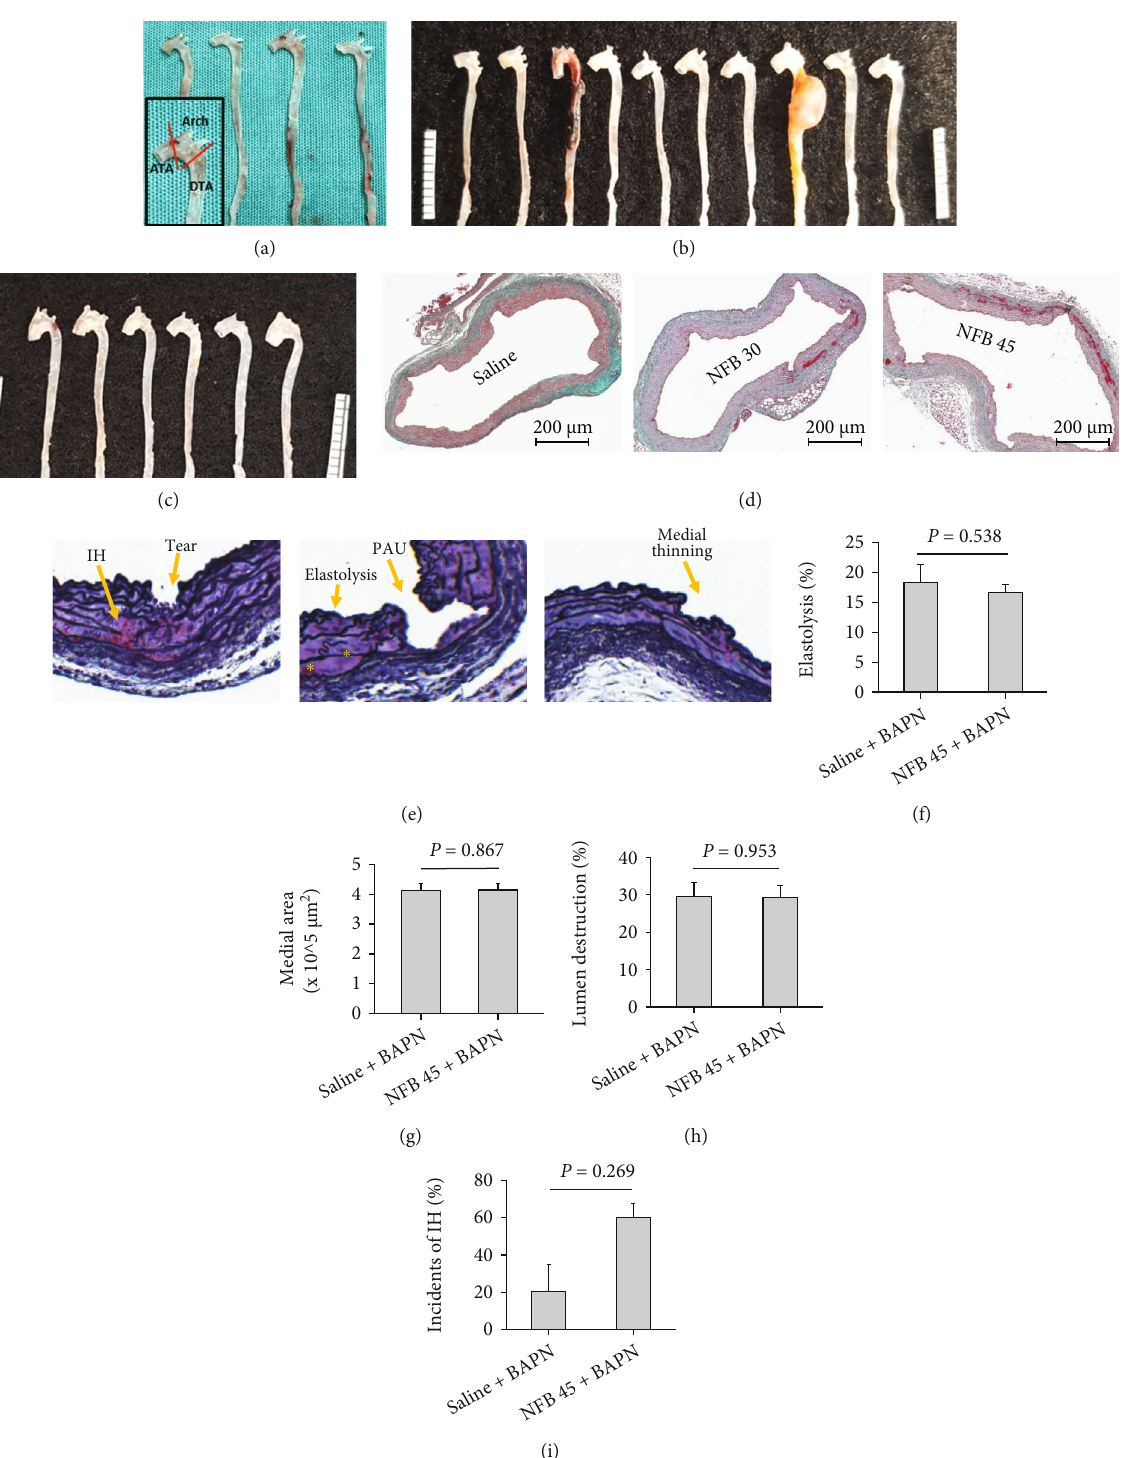
Figure 3: Nicotine free base (NFB) at doses su ffi cient to exaggerate aortic dilation may not worsen medial degeneration. (a – c) Gross appearance of TAADs in mice treated with saline ((a), n = 7 ) or NFB at dosages of 30.0 mg/kg/day (NFB 30, n = 10 , (b)), or 45.0mg/kg/day (NFB 45, n = 10 , (c)). Ruler scale: mm. (d) Masson ’ s staining of TAADs after undergoing the indicated treatments. Note the similarity in medial structural defects between these TAADs. (e) Typical pathologies disclosed with Movat ’ s staining. IH: intramural hemorrhage; PAU: penetrating aortic ulcer. (f – i) Morphometric analyses in TAADs treated with saline ( n = 10 ) or NFB ( n = 6 ); (f) fractional area with elastolysis in the residual media; (g) cross-sectional area of the medial layer; (h) percentage of area with structural destruction on the luminal surface; and (i) incidence of